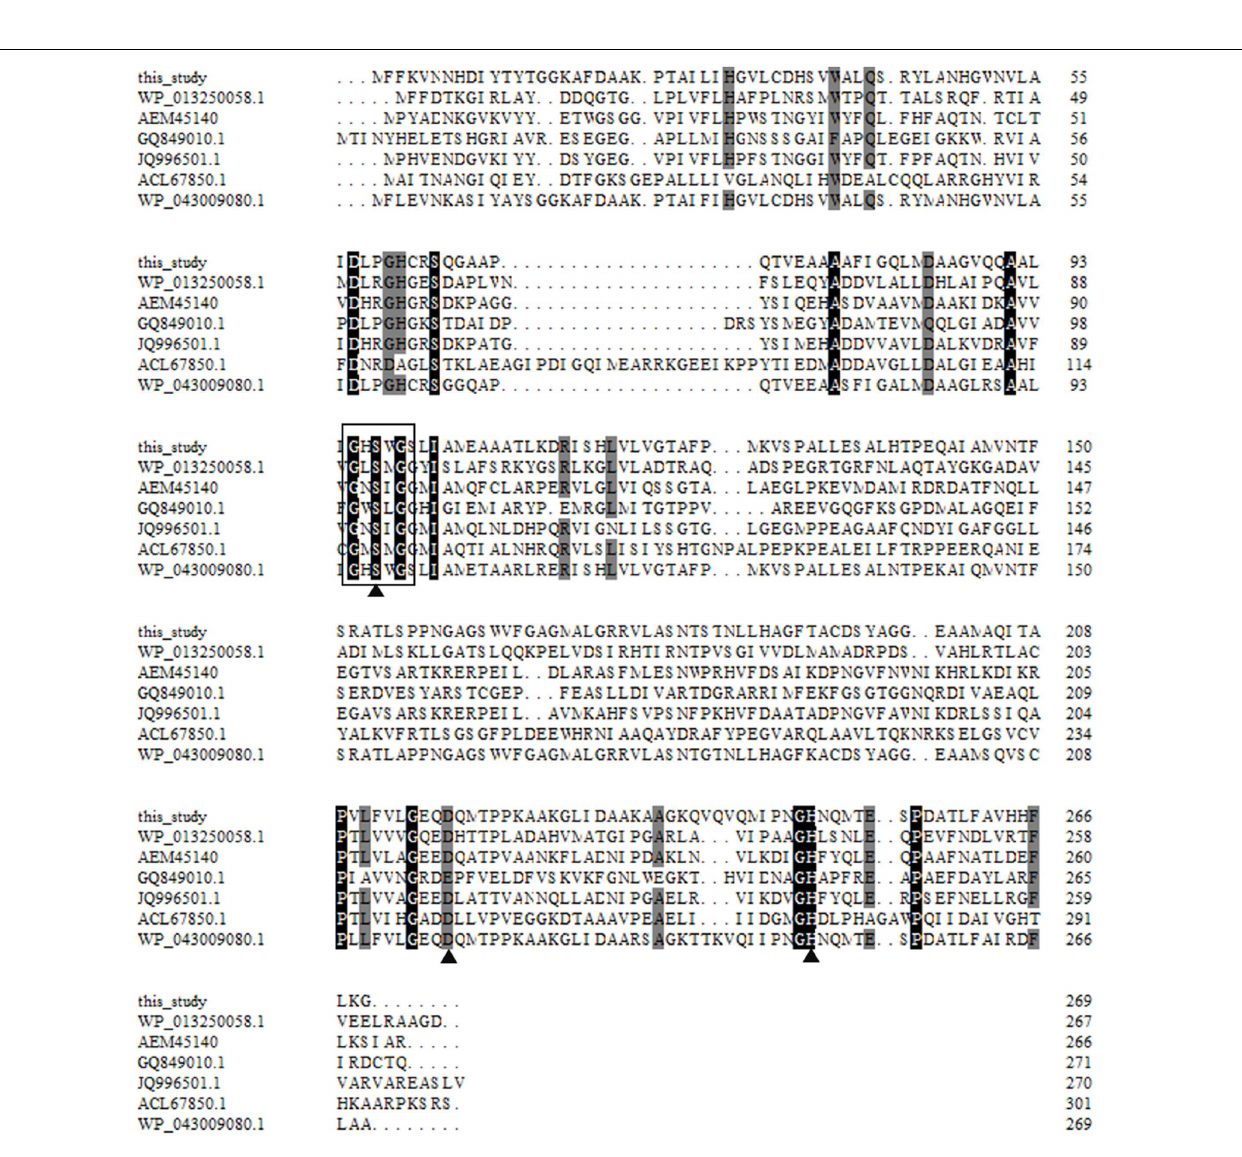
FIGURE 2 | Multiple amino acid sequence alignment of Aii810. Multiple alignment of the partial amino acid sequences containing the conserved motifs of G-X-S-X-G and putative catalytic triad residues of alpha/beta hydrolase family proteins. Except Aii810 (this study), other protein sequences were retrieved from GenBank (http://www.ncbi.nlm.nih.gov). The accession numbers of the aligned sequences are for the following organisms: WP_013250058.1, putative 3-oxoadipate enol-lactonase from Nitrospira defluvii ; AEM45140, hypothetical protein from uncultured organism; GQ849010.1, alpha/beta hydrolase fold protein from Ochrobactrum sp. T63; JQ996501.1, esterase (est816) gene from uncultured bacterium; ACL67850.1, lipolytic enzyme from uncultured bacterium; and WP_043009080.1, alpha/beta hydrolase from Comamonas testosterone . The alignment was carried out using the Clustal W method. The open boxes